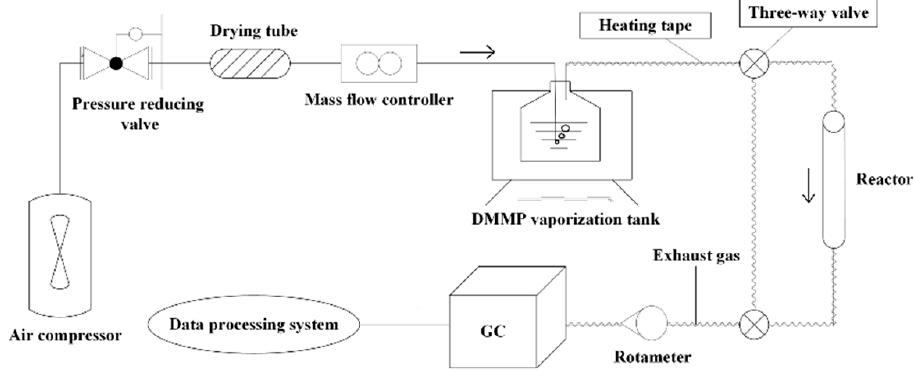
Figure 1. Schematic diagram of the device for thermocatalytic decomposition.